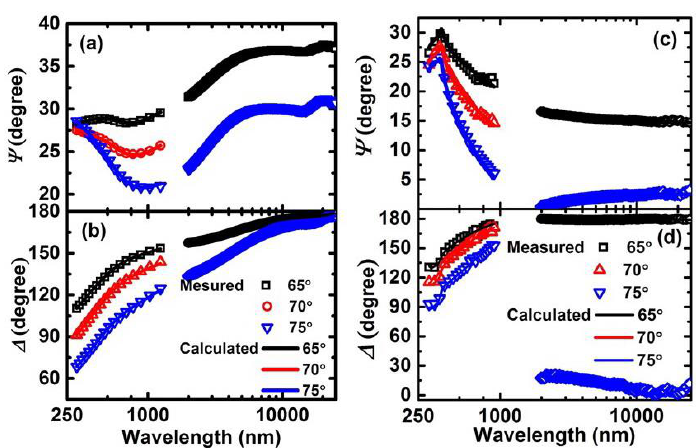
Figure 2. Measured (symbol) and fitted (line) ellipsometric parameters for ( a , b ) bulk Cr film, and ( c , d ) ultrathin Cr film.